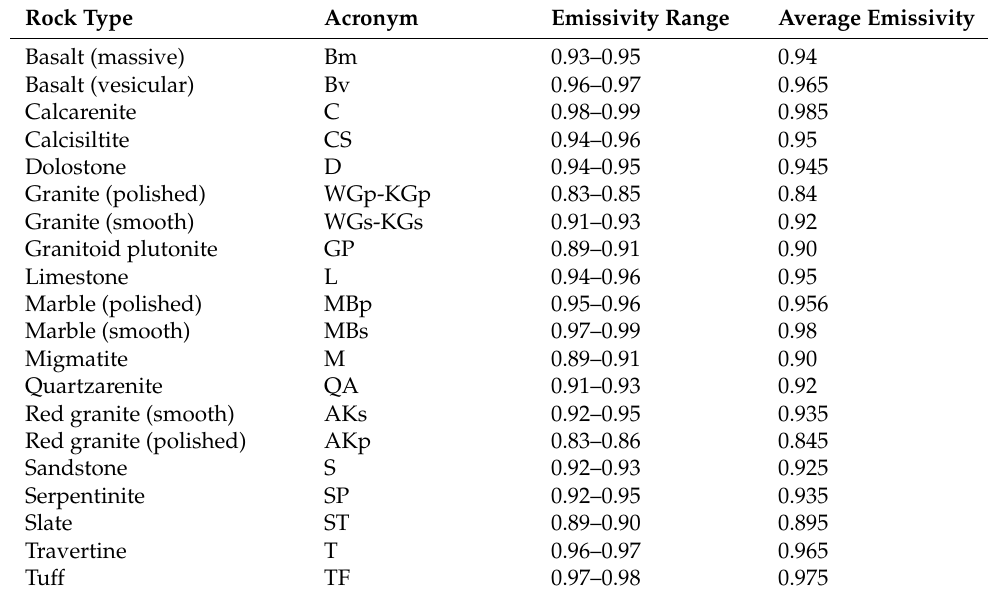
Table 2. Emissivity values estimated for the tested rock